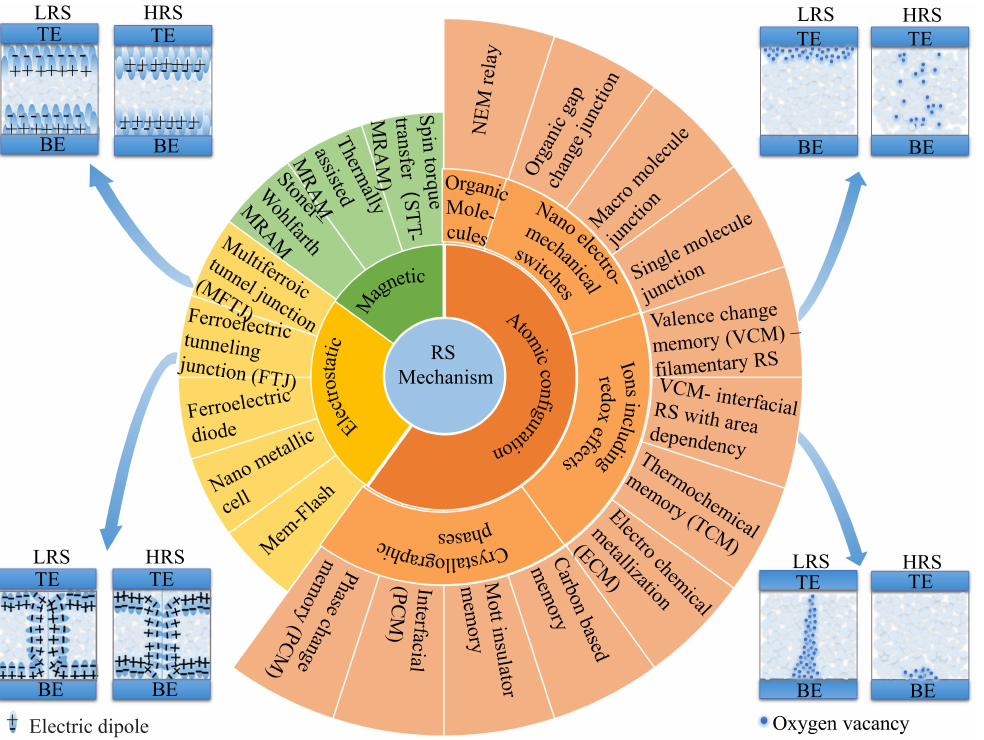
Figure 4. Classification of physical switching mechanisms in memristive devices, with especially demonstrated RS mechanisms in